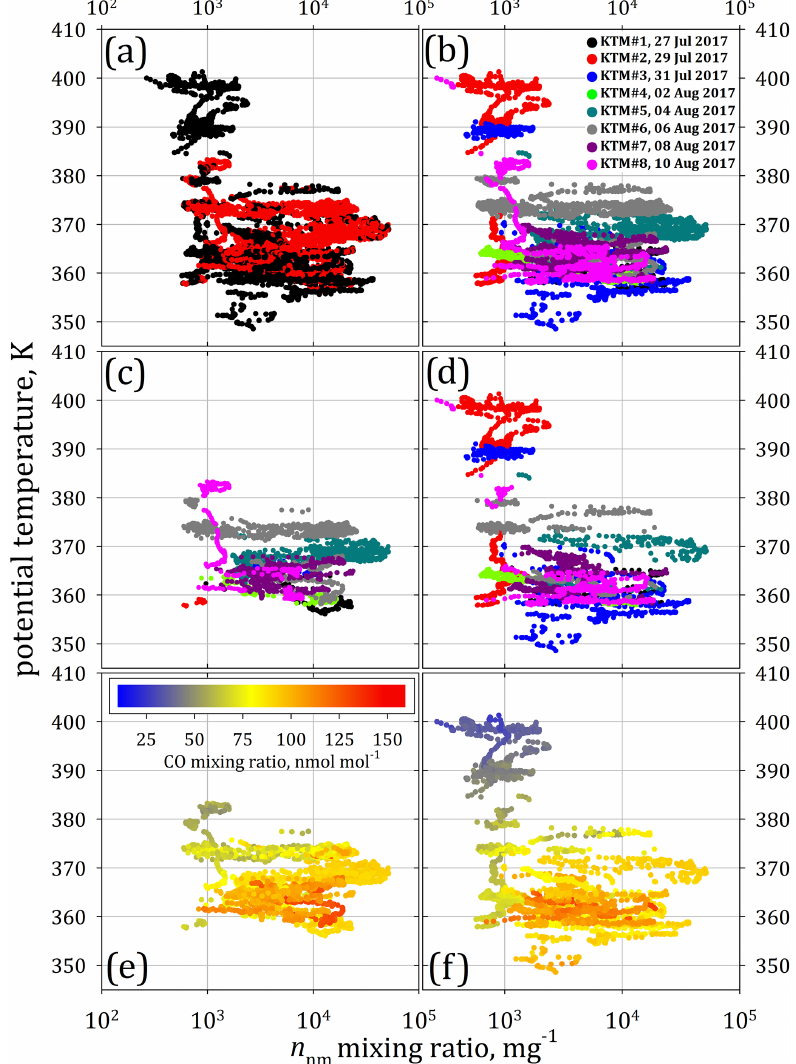
Figure 3. Vertical profiles of the mixing ratio (1Hz resolved) of aerosols in the nucleation-mode size range ( n nm ) versus the potential temperature ( θ) . (a) All data separated concerning coincident detection of cloud (ice) particles (black: N ice = 0cm − 3 ; red: N ice > 0cm − 3 ) and (b) all data coloured in reference to the flight date (c) exclusively for N ice > 0cm − 3 and (d) when N ice = 0cm − 3 . In panels (e) and (f) , in-cloud and clear-air measurements are distinguished as in intermediate panels (c, d) and coloured with reference to carbon monoxide (CO) mixing